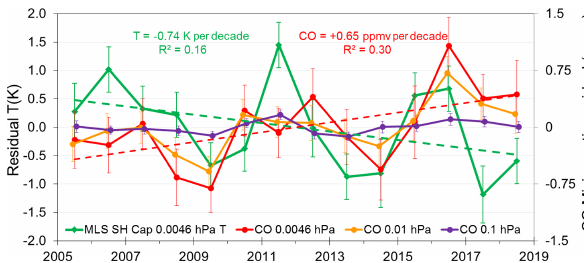
Figure 7. Comparison of Aura/MLS SH polar cap (65–85 ◦ S) win- ter residual temperatures at 0.0046hPa (green line; dashed linear fit − 0.74K per decade) with CO mixing ratio at 0.0046, 0.01, and 0.1hPa (red line with dashed fit + 0.65ppmv per decade, orange line, and purple line respectively). Data are averaged over months AMJJAS and have had seasonal and solar cycle variations sub-